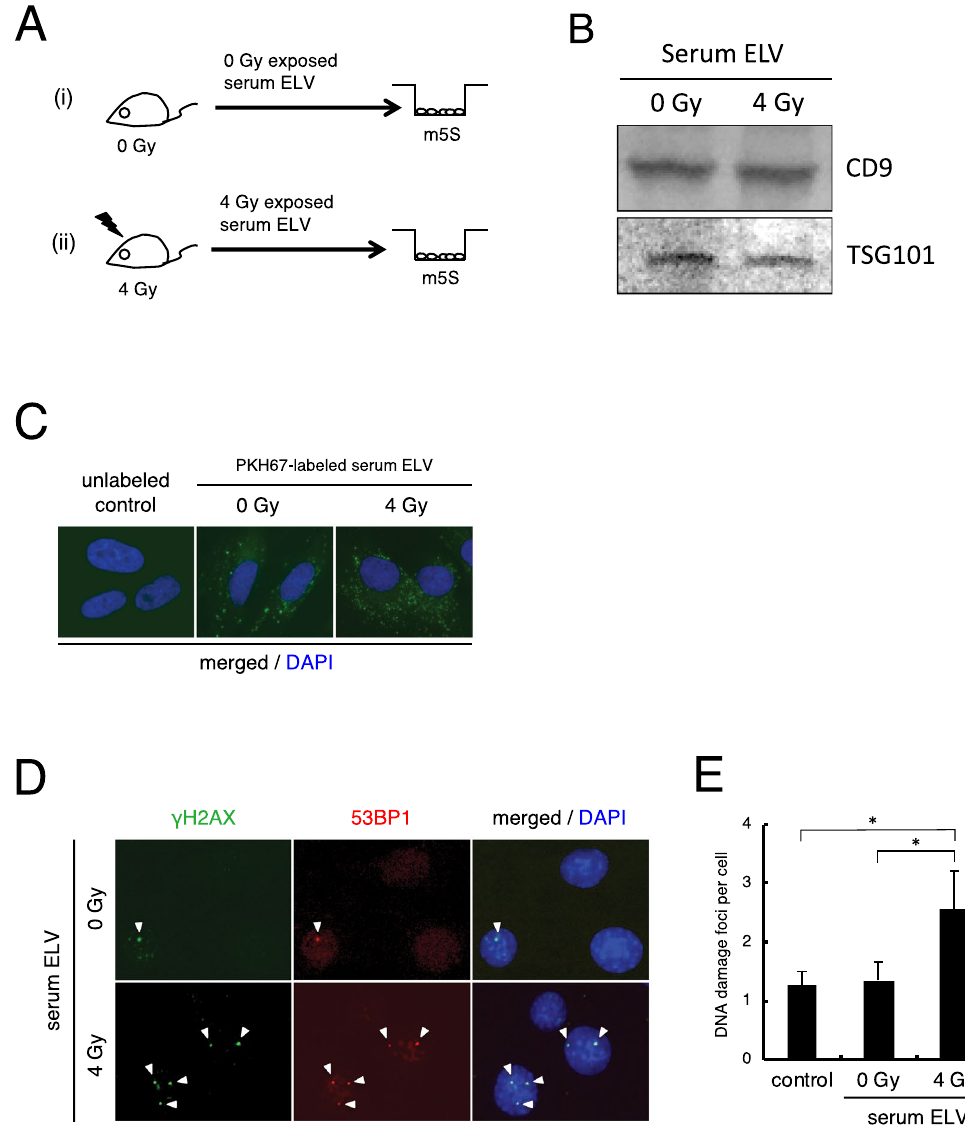
Figure 2. Induction of DNA damage by ELV obtained from irradiated mouse serum. ( A ) A schematic view of the experimental protocol. ( B ) Detection of CD9 and TGS101 proteins in the ELV in serum from control mouse or 4 Gy exposed mouse by Western blotting. Full-length blots are present in Supplementary Fig. S2. ( C ) Representative image of PKH67 labeled ELV (green) derived from control mouse serum or 4 Gy irradiated mouse serum up-taken by treated m5S cells, counterstained with DAPI (blue). ( D ) Representative images of γ H2AX (green) and 53BP1 (red) focus-positive cells treated with un-irradiated mouse ELV or 4 Gy irradiated ELV, counterstained with DAPI. ( E ) The frequency of DNA damage foci in un-treated cells (control), cells treated with un-irradiated (0 Gy) mouse ELV or cells treated with irradiated (4 Gy) ELV. Values are represented as mean ± standard error ( E ), with significant differences between indicated groups ( * ) calculated by Chi- square test ( p <